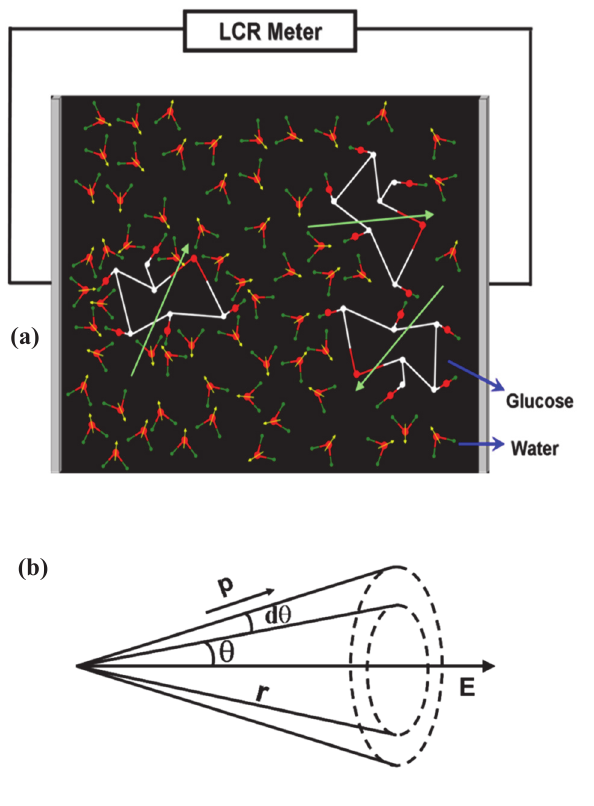
Fig. 1: (a) Schematic representation of water-water, glucose-water and glucose-glucose dipole interactions in glucose-DI water solution with randomly oriented dipoles under the effect of an external electric field; (b) Schematic diagram to describe the conical solid angle included between θ and ( θ +d θ )